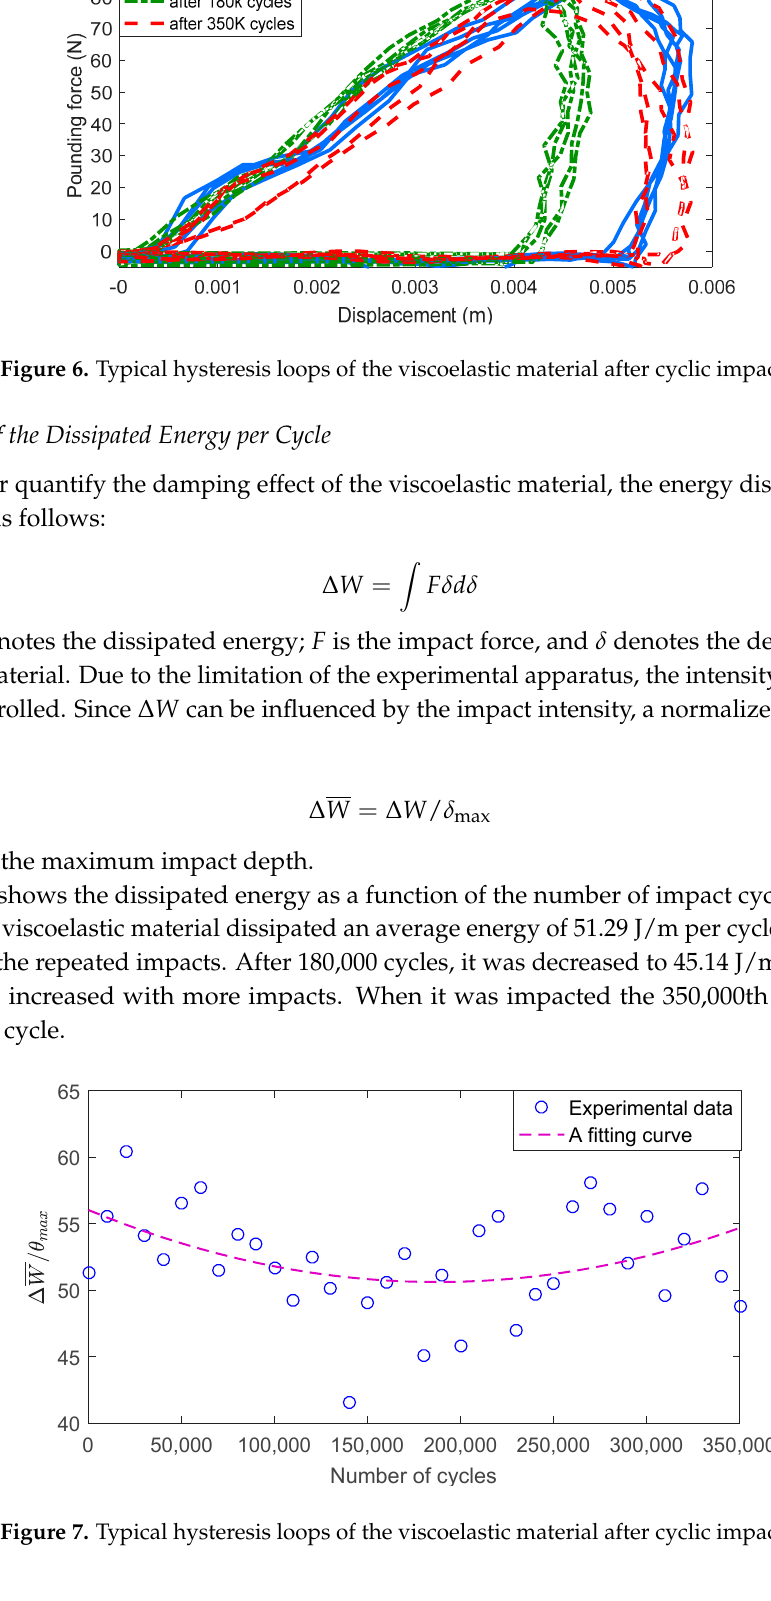
Figure 7. Typical hysteresis loops of the viscoelastic material after cyclic impacts.